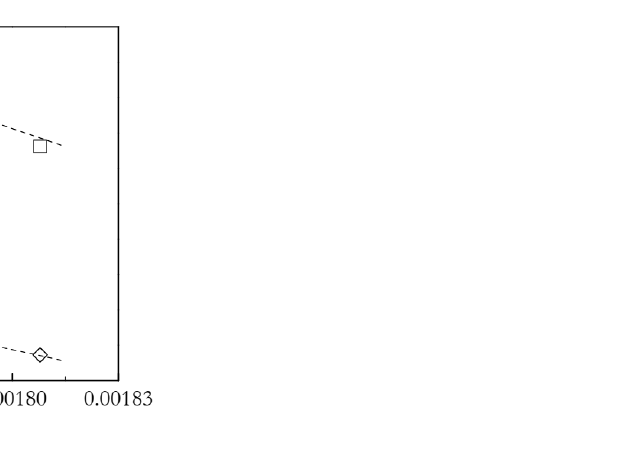
Figure 9. Arrhenius plots of the heating function. Squares and diamonds represent, respectively,